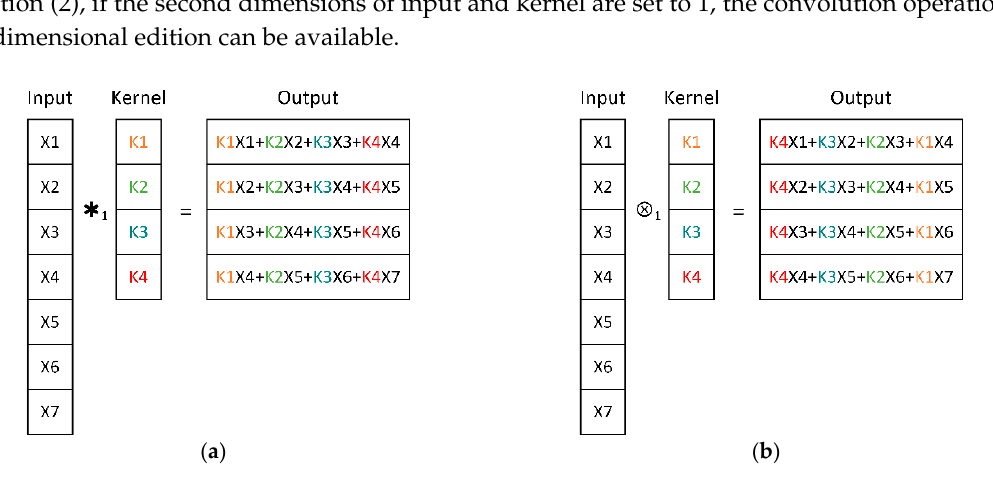
Figure 1. One-dimensional convolution operation in: ( a ) a convolutional neural network CNN; ( b ) mathematical definition.